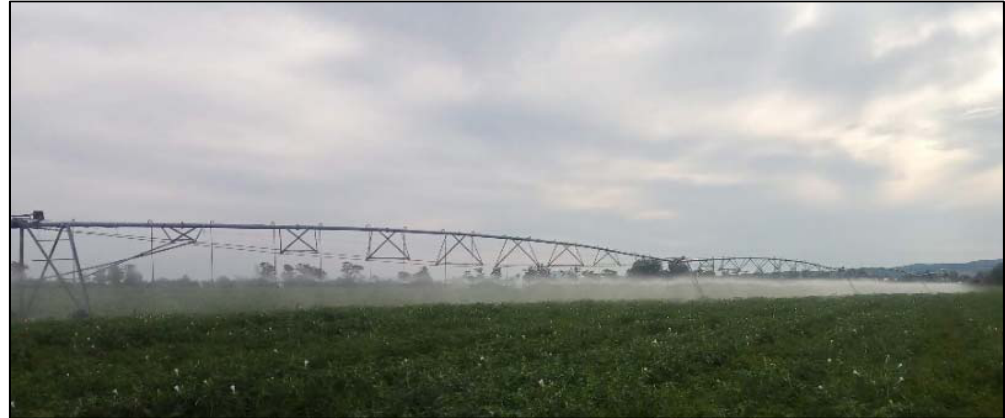
Figure 2. Example of used irrigation design used in experimental measurement which is depicted in practical conditions.